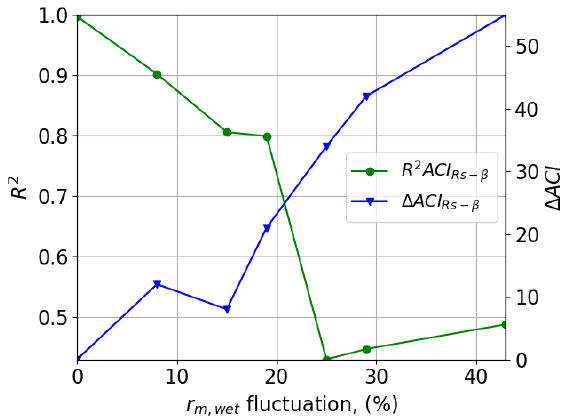
Figure A5. R 2 (left axis) and ∆ ACI (right axis) with respect to the r m , wet uncertainty. R 2 N d − AOD and ∆ ACIref f − AOD (not shown) are identical to R 2 N d − β and ∆ ACIref f − β because the uncer- tainty of r m , wet in the vecinity of the CBH does not affect the dry aerosol properties.